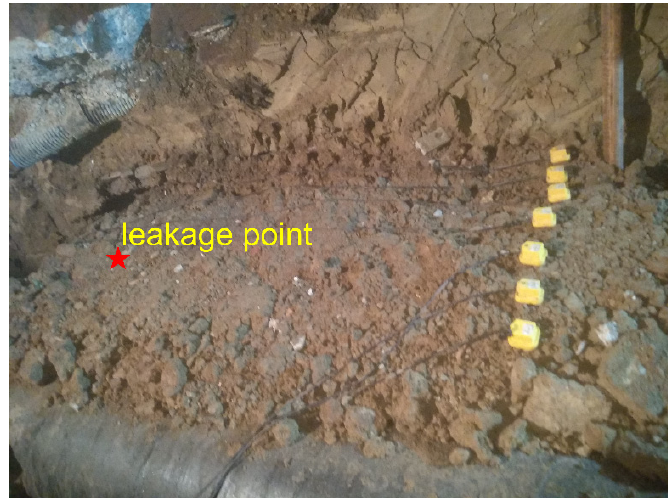
Figure 5. Ground surface vibration measurement using the sensor array at the distance of 1.5 m from the leak.